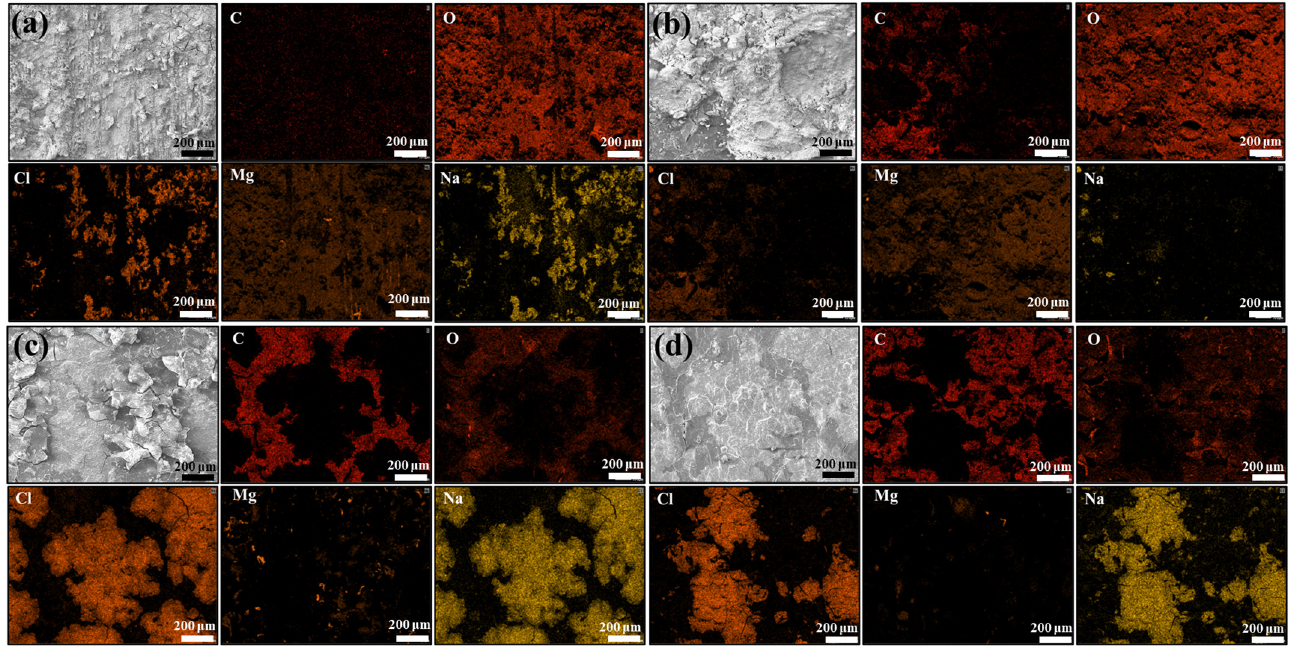
Figure 10. The microscopic morphology and EDS patterns of ( a ) bare AZ31B alloy, ( b ) Ce(IV)/PEI/PAA, ( c ) Ce(IV)/PEI-C/PAA, and ( d ) Ce(IV)/PEI-C/PAA-GO immersed in a 3.5 wt % NaCl solution for 72 h.